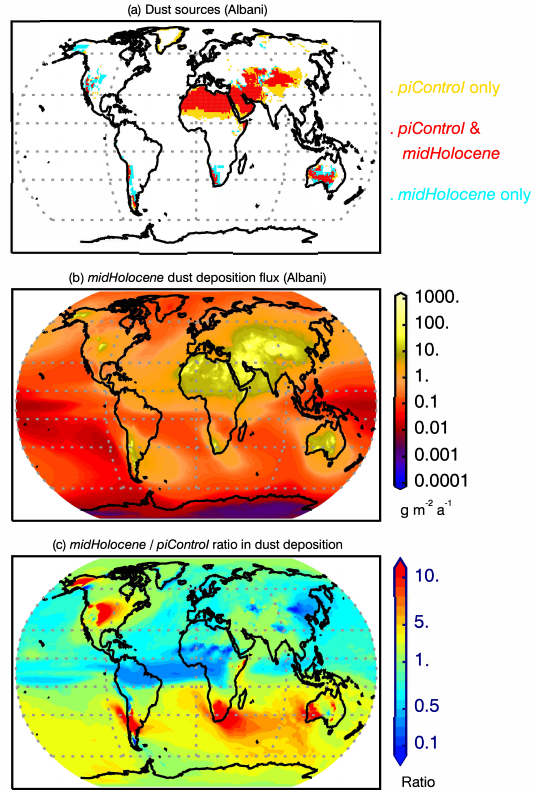
Figure 6. Maps of dust from observationally constrained sim- ulations with the Community Climate System Model for the midHolocene (Albani et al., 2015). (a) Active sources for dust emissions for the midHolocene and the piControl (Albani et al., 2016). (b) Dust deposition (gm − 2 year − 1 ) in the mid- Holocene . (c) Ratio of midHolocene / piControl dust